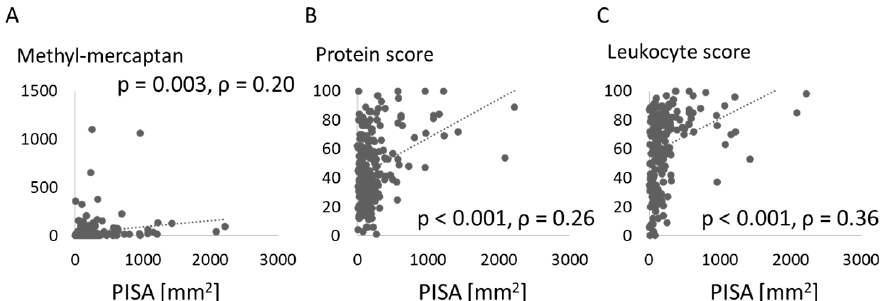
Figure 5. Association between oral parameters and periodontal inflamed surface area. Methyl- mercaptan in breath ( A ) and protein ( B ) and leukocyte ( C ) scores in saliva are compared with periodontal inflamed surface area (PISA).